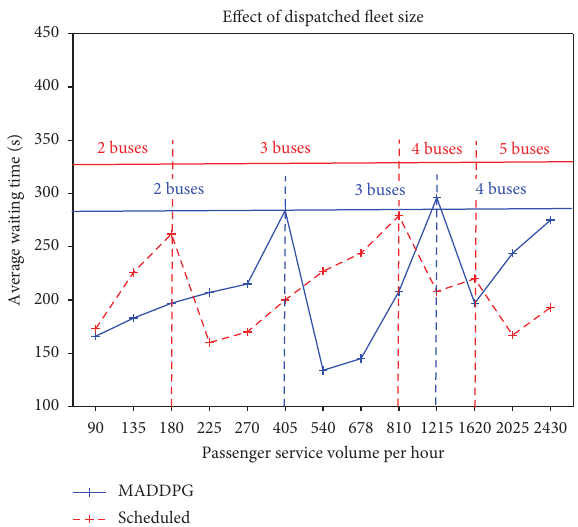
Figure 10: Effect of the fleet size on the passenger wait time with the MADDPG and SCHEDULED methods.